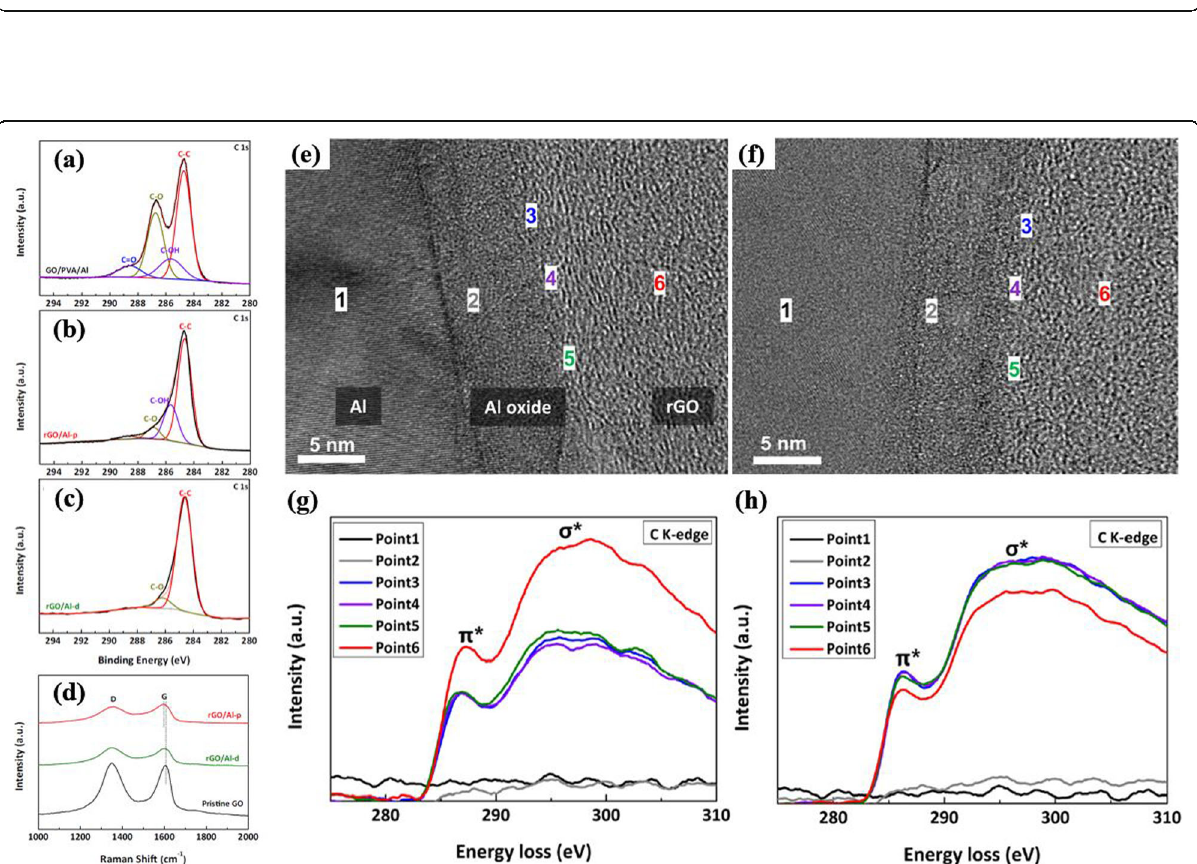
Fig. 7 ( a ) Schematic of bonding features for FLG/Al and FLG/Ti composites. HRTEM images of ( b ) FLG/Ti and ( c ) FLG/Al composites and their corresponding EELS spectra taken from the FLG/Ti and FLG/Al composites (Shin et al. 2015b). Reprinted from Shin et al. (2015b) ( Sci. Rep. 5, 16,114) with Scientific Report ’ s permission